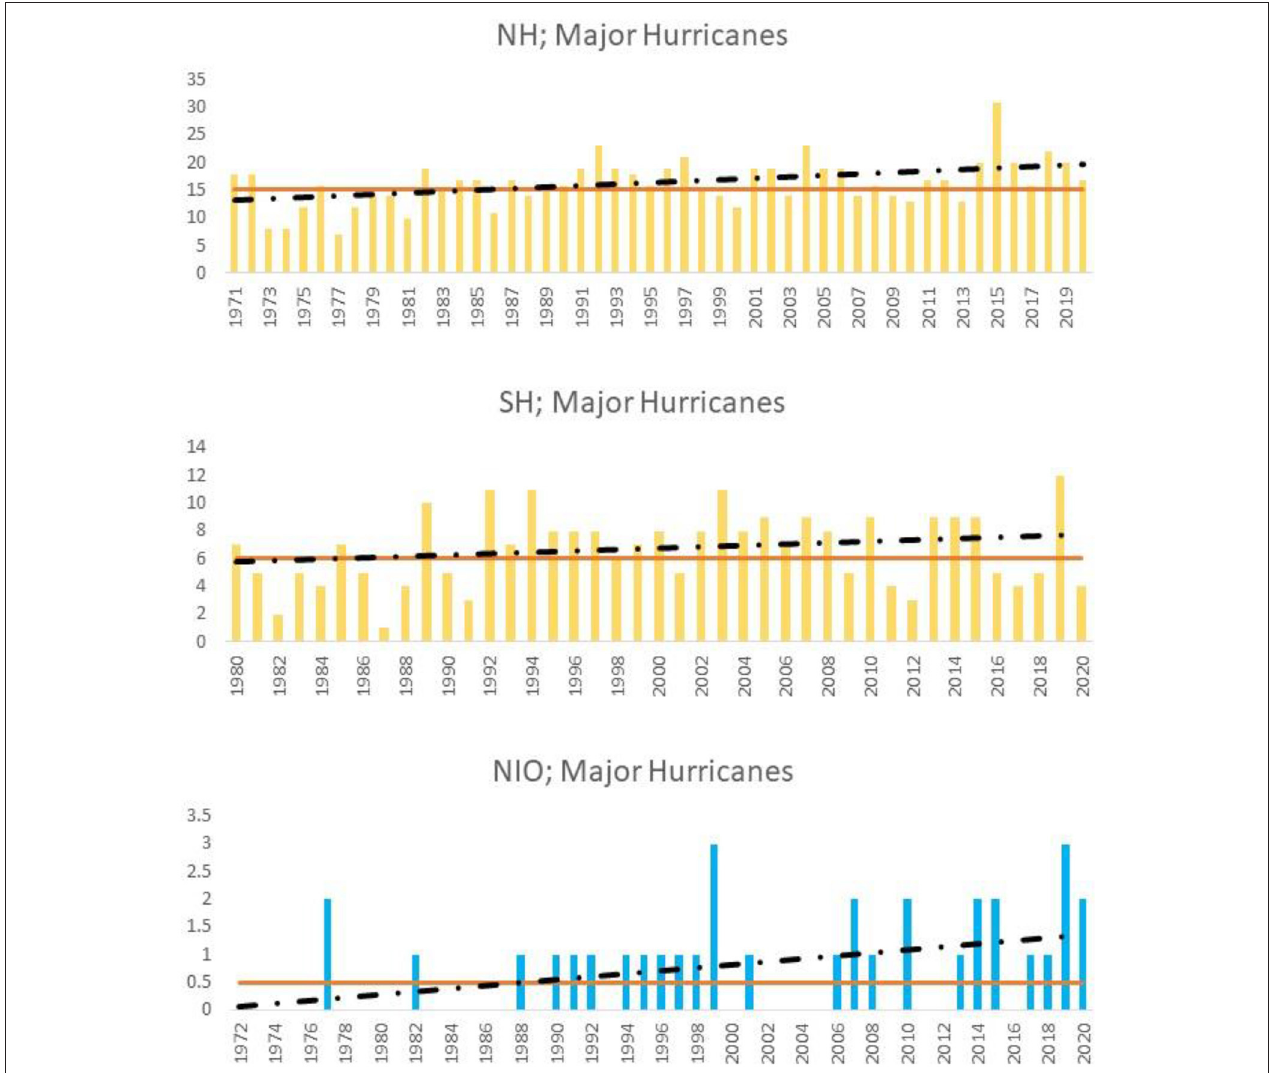
FIGURE 1 | The number of category 3 + hurricanes that occurred in the Northern and Southern hemispheres and the NIO (black dotted line indicates a linear trend, and orange line indicates significance at the 95% confidence level)